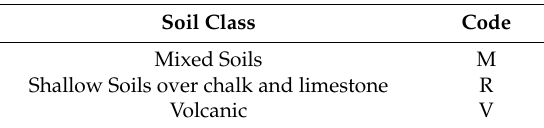
Table 2. Ground type and the code of each class.